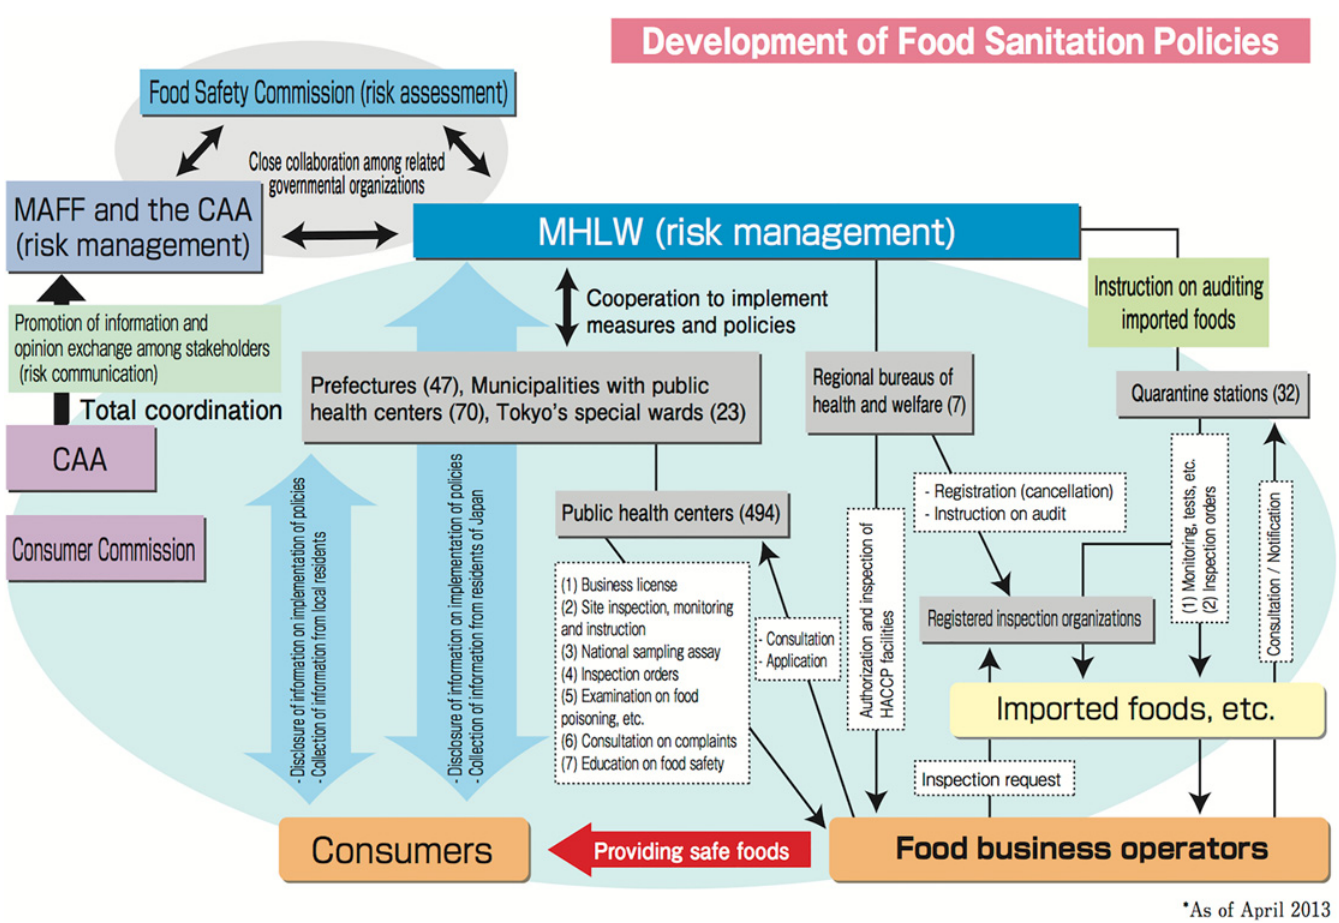
Fig 2. Responsibilities and roles of different stakeholders in development and implementation of food safety